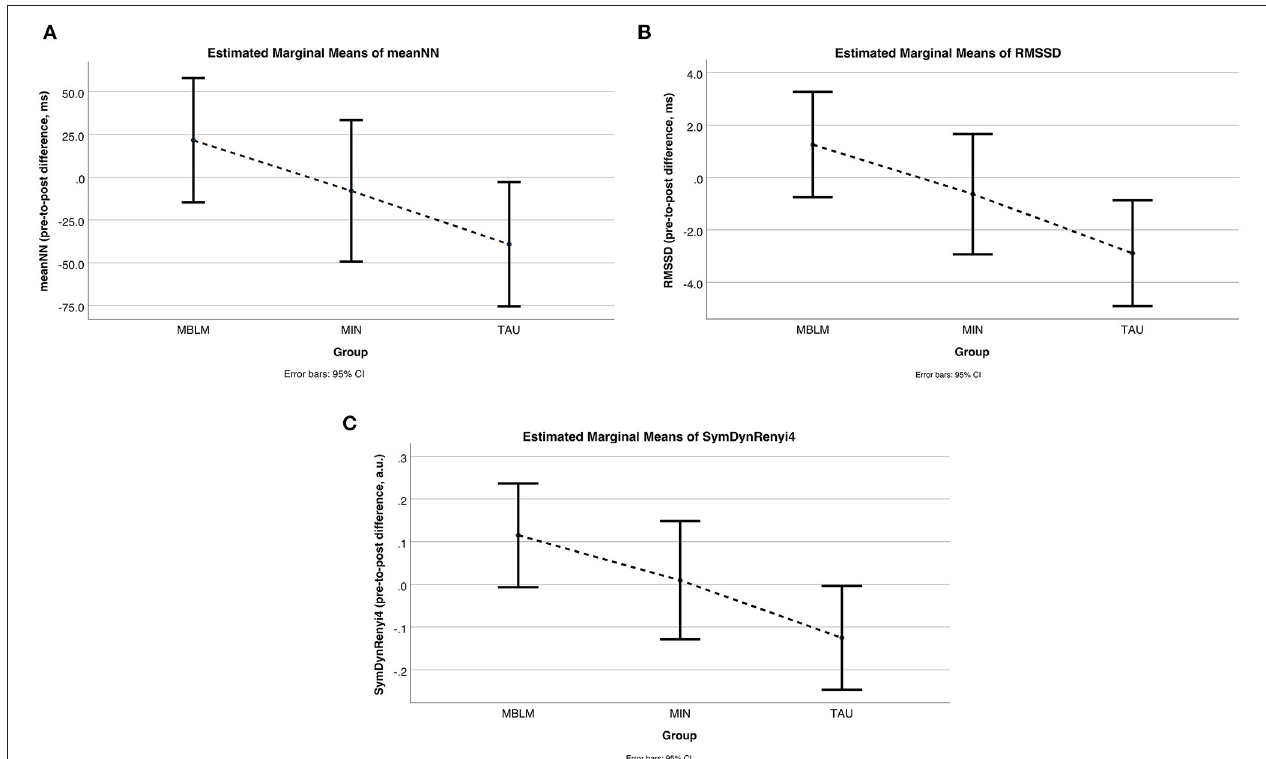
FIGURE 2 | HRV changes (pre-to-post differences) within the three treatment groups. Plots from results of estimated marginal means with pre-to-post differences per group indicating improved HRV for Meditation Based Lifestyle Modification (MBLM), almost no changes for drug continuation therapy (MINIMAL treatment), and deterioration for treatment as usual (TAU); (A) Differences in meanNN (average beat-to-beat interval as negative pendant to average heart rate); (B) Differences in RMSSD (root mean square of successive beat-to-beat interval differences as measure for short-term or vagal activity); (C) Differences in symdynrenyi4 (Renyi4 entropy of symbolic dynamic patterns in the beat-to-beat interval series as measure for its